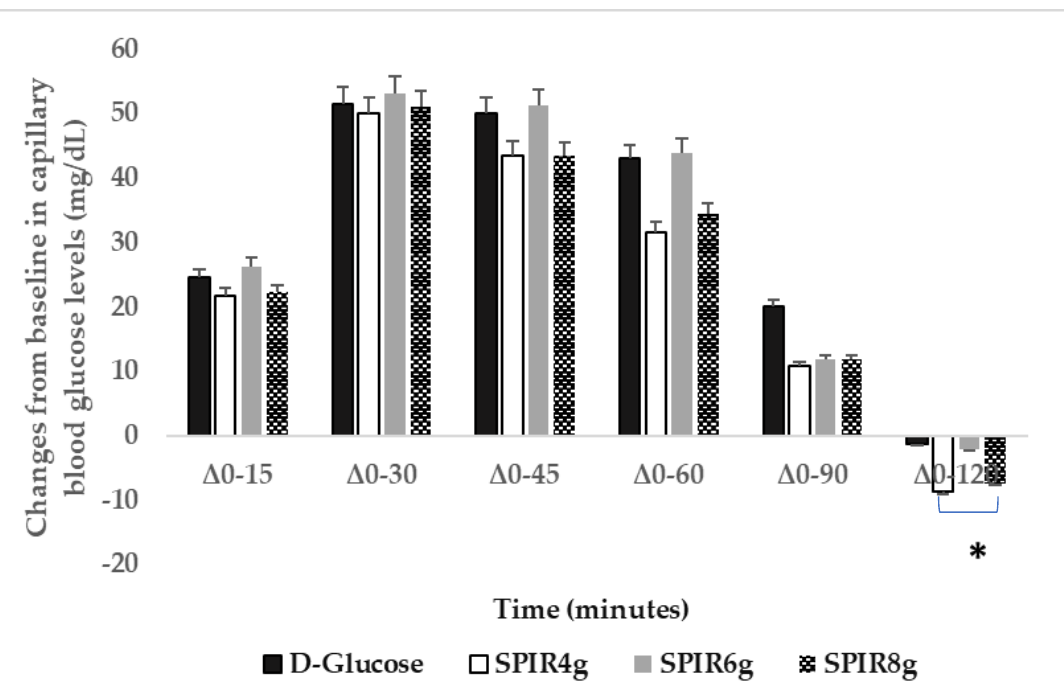
Figure 3. Changes from baseline ( Δ ) for capillary blood glucose concentrations (mg/dL) after the consumption of test beverages, 50 g D-glucose with 4 g spirulina, 50 g D-glucose with 6 g spirulina, 50 g D-glucose with 8 g spirulina, and the reference beverage (50 g D-glucose) ( n = 13). Data are means ± SEM. The asterisk denotes a statistically significant difference at the 0.05 level, as derived from repeated measures ANOVA followed by post hoc Tukey’s test. The models included the factors “subject” (id), “sequence” for inter-subject variation, and “period” and “treatments” to account